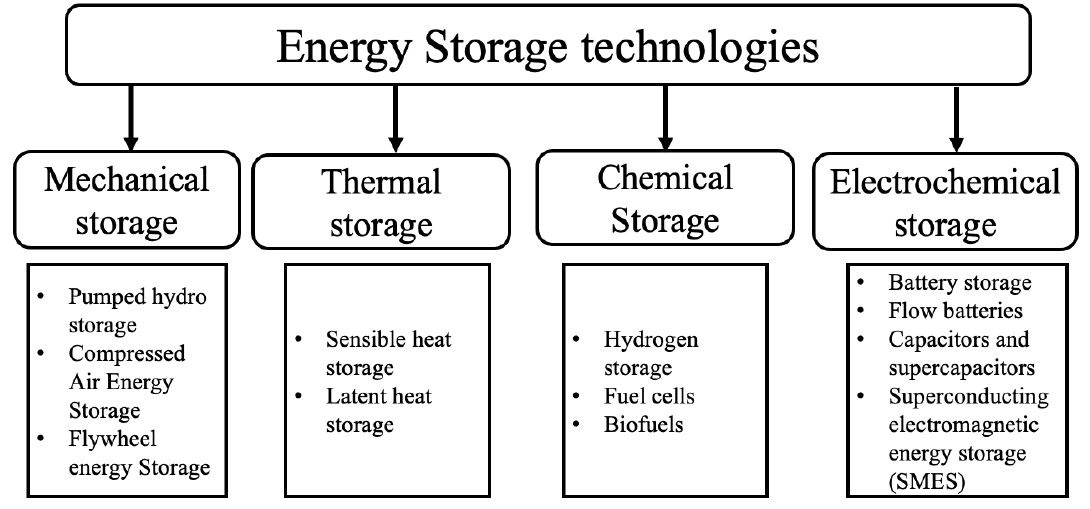
Figure 2. General classification of available storage technologies.